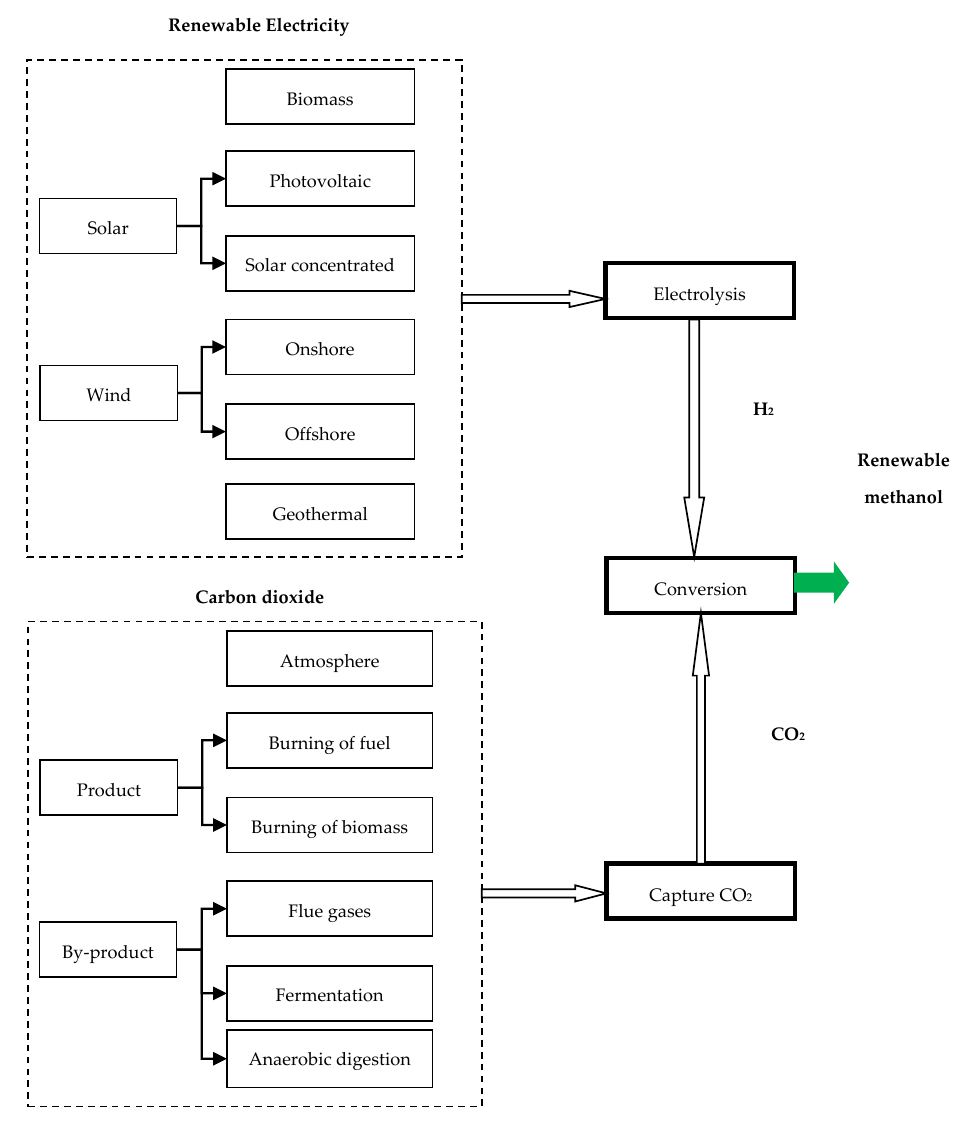
Figure 13. Renewable methanol production.